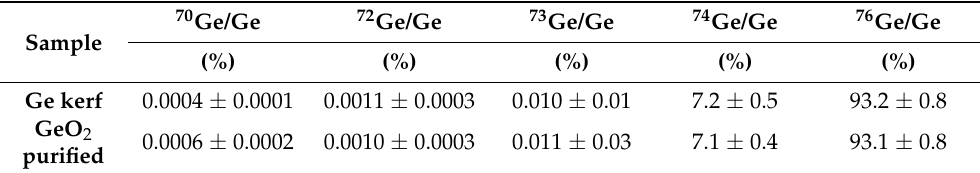
Table 8. Isotope